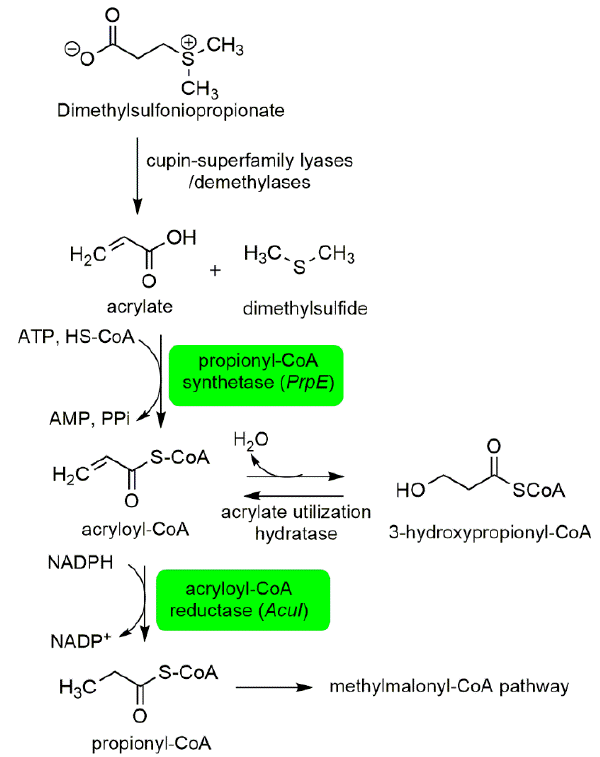
Figure 4. Dimethylsulfoniopropionate degradation through the cleavage pathway. Propionyl-CoA synthetase and acryloyl-CoA reductase (in green) were identified in P. bahamense using Marinovum algicola reference database. These enzymes are mainly involved in the cleavage pathway for the degradation of dimethylsulfoniopropionate. Propionyl-CoA synthetase catalyzes the conversion of acrylate to acryloyl-CoA. Acryloyl-CoA is then converted to propionyl-CoA through catalysis of acryloyl-CoA reductase. The presence of these proteins in the proteome of P. bahamense corroborates the previous reports on the role of associated bacteria in this process. This process is also likely to contribute to the cellular energetics of P. bahamense through the generation of propionyl-CoA, an intermediate for the biosynthesis of precursors in the Krebs cycle. Highlighted proteins in green were detected in the present study. Figure was adapted from Bullock et al., 2017